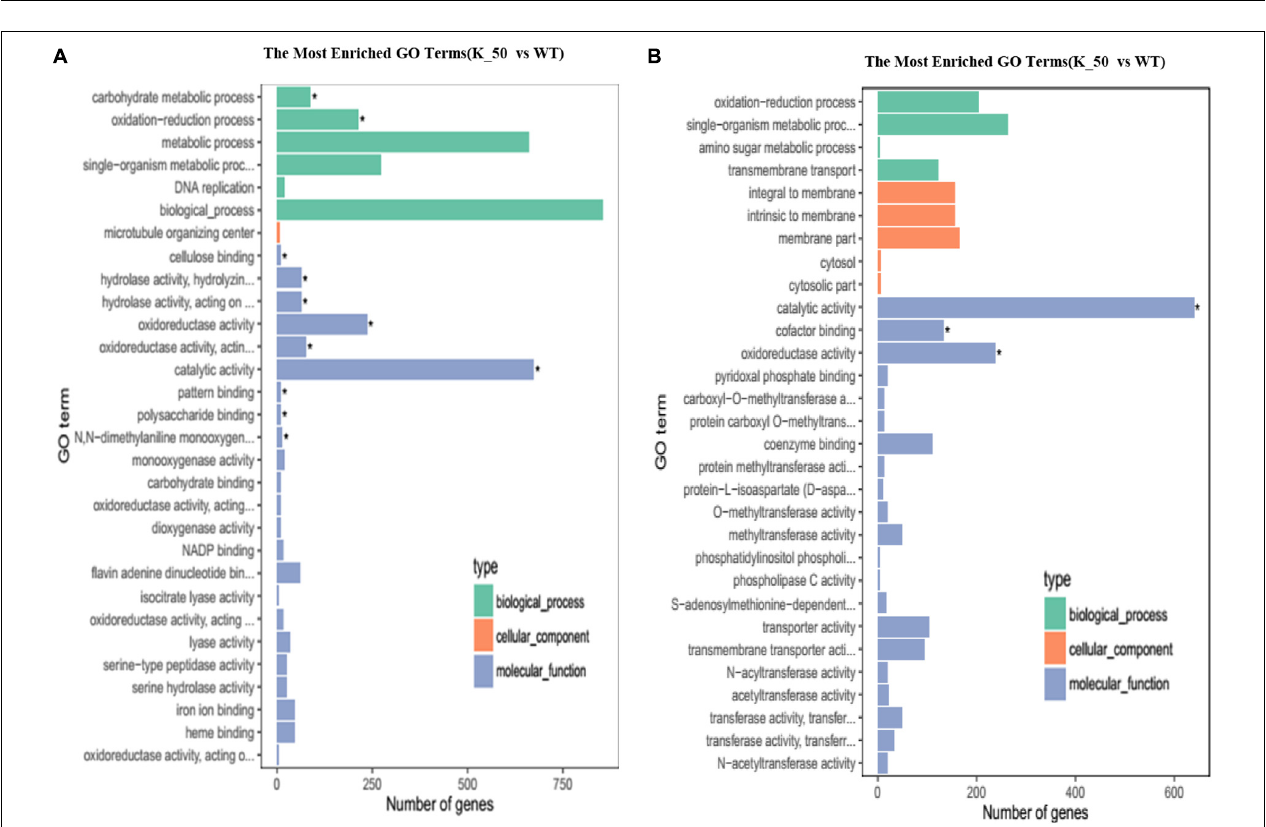
FIGURE 6 | Gene ontology (GO) analysis of DEGs. (A) The most enriched GO terms. The downregulated DEGs of each category are shown on the graph. (B) The upregulated DEGs of each category are presented on the graph as related to BP, CC, and MF. BP, biological process; CC, cellular component; MF, molecular function. ∗ indicates the significantly enriched